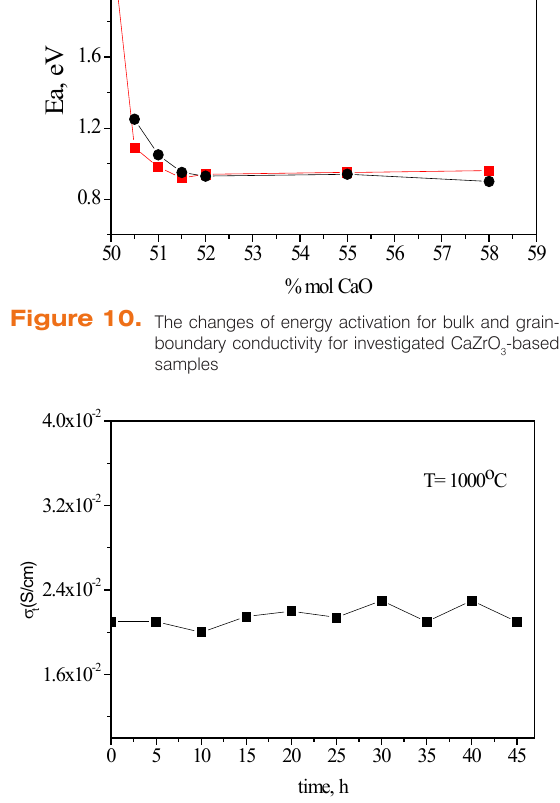
Figure 11. The time dependence of total electrical conductivity ( s ) vs. time for non-stoichiometric CaZrO t (51 % mol CaO).